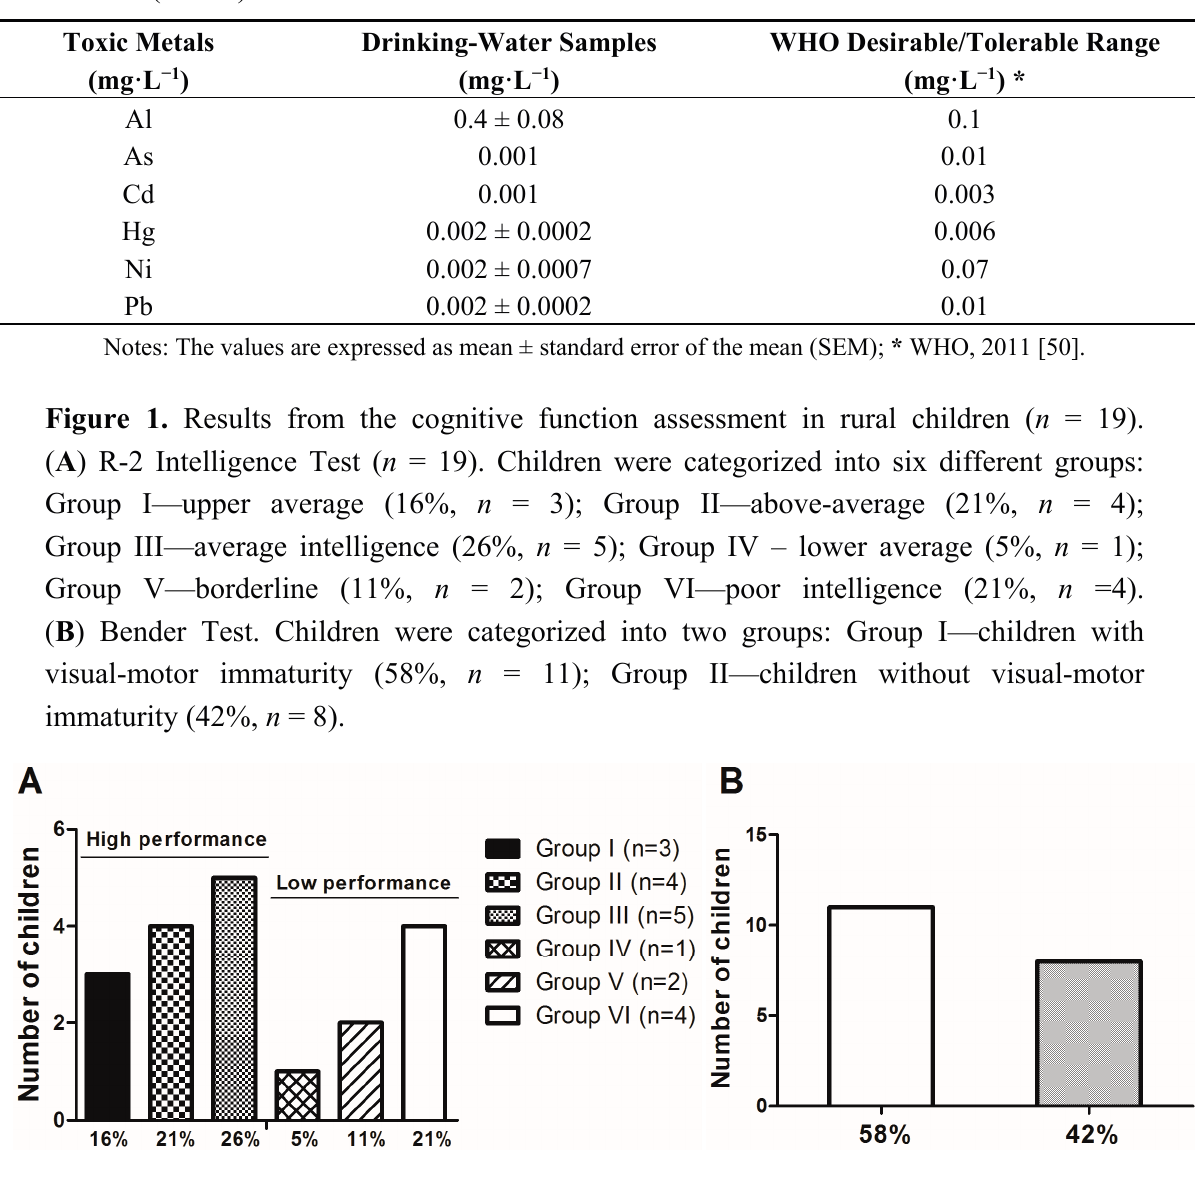
Table 4. Concentrations of toxic metals in drinking water from the households of rural children ( n = 11).